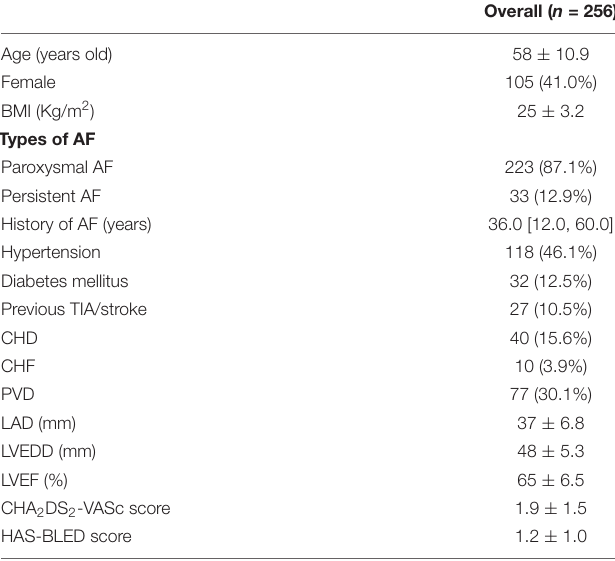
TABLE 1 | Baseline